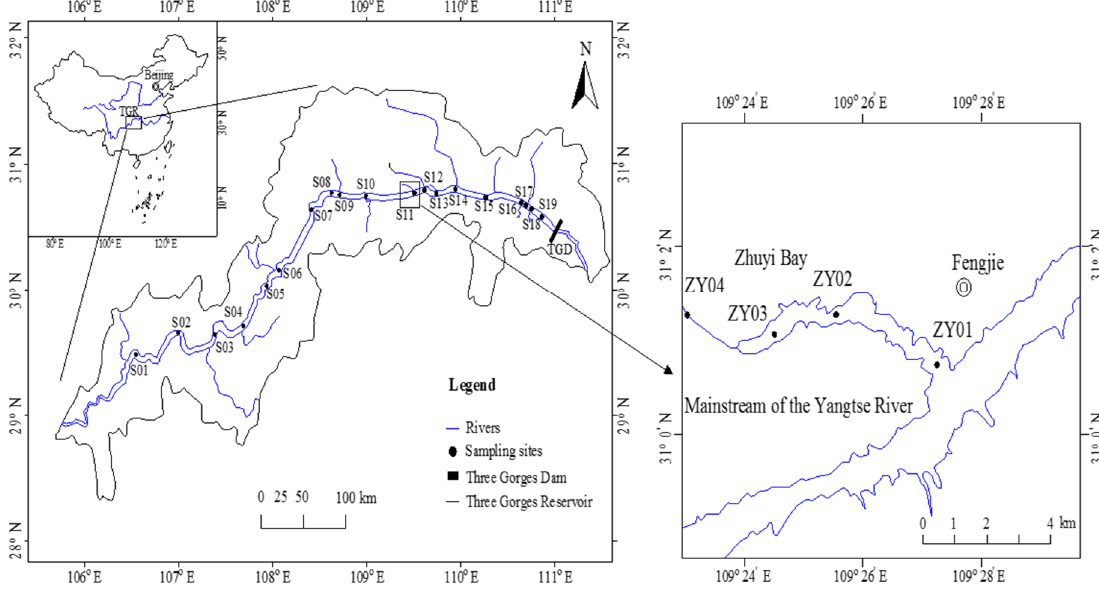
Figure 1. Sampling sites of the Three Gorges Reservoir mainstream and Zhuyi